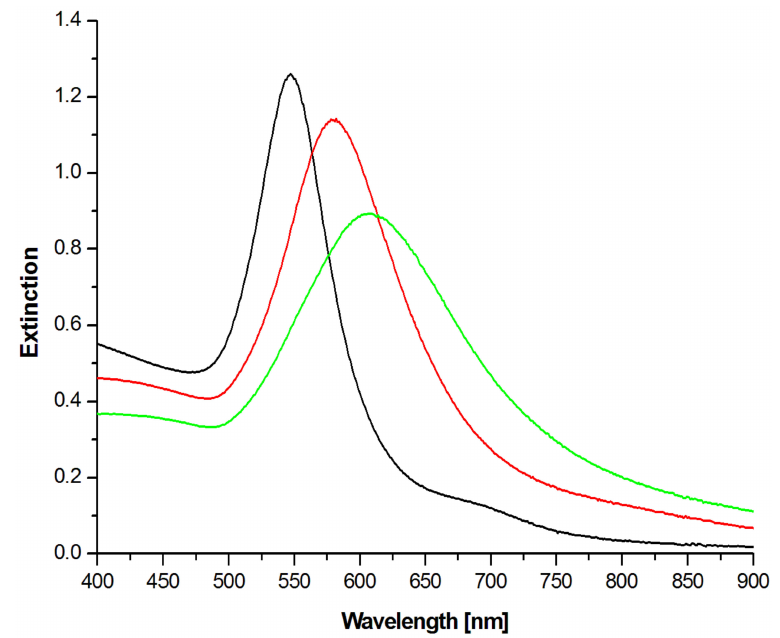
Figure 9. UV-Vis excitation spectra of trisoctahedral gold nanoparticles of various sizes: black—70 nm, red—94 nm, and green—115 nm.